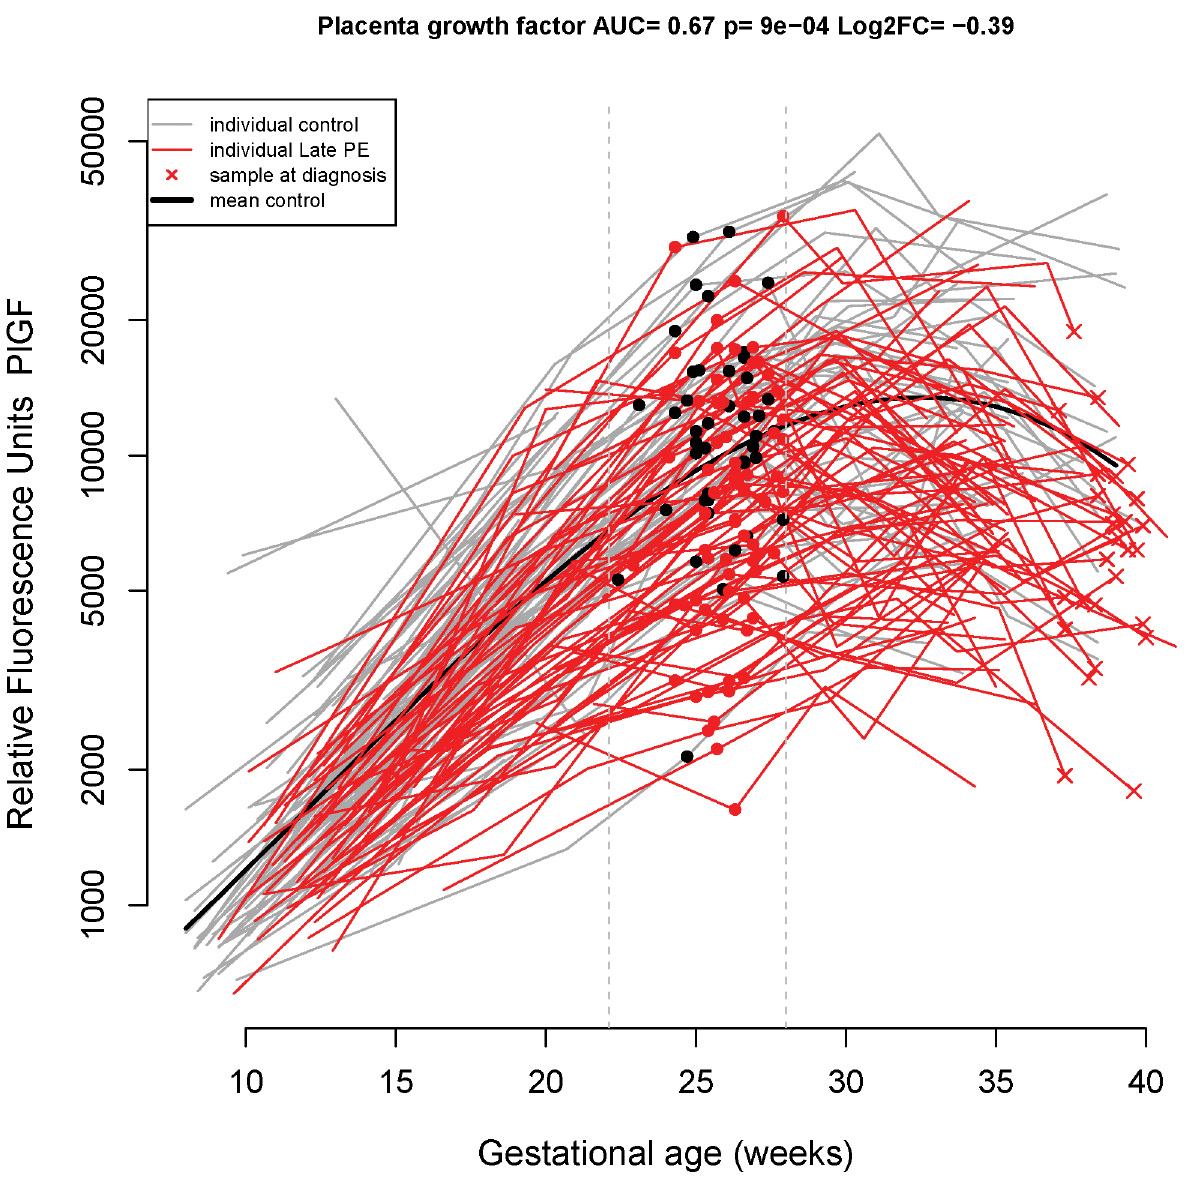
Fig 4. Longitudinal maternal plasma PlGF abundance in normal pregnancy and late-onset preeclampsiacases,highlighting differences in the 22.1–28weeks interval. See the Fig 1 legendfor more details.